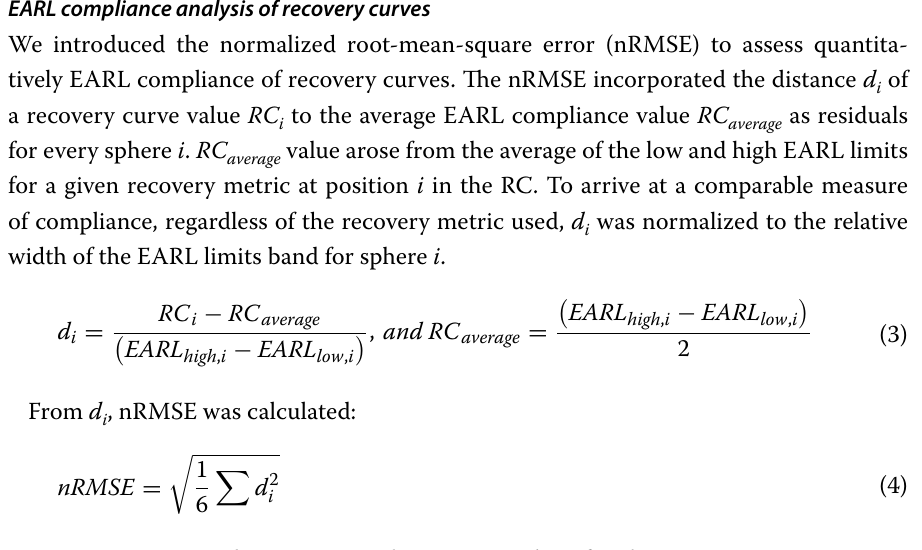
for total‑body scanners was max